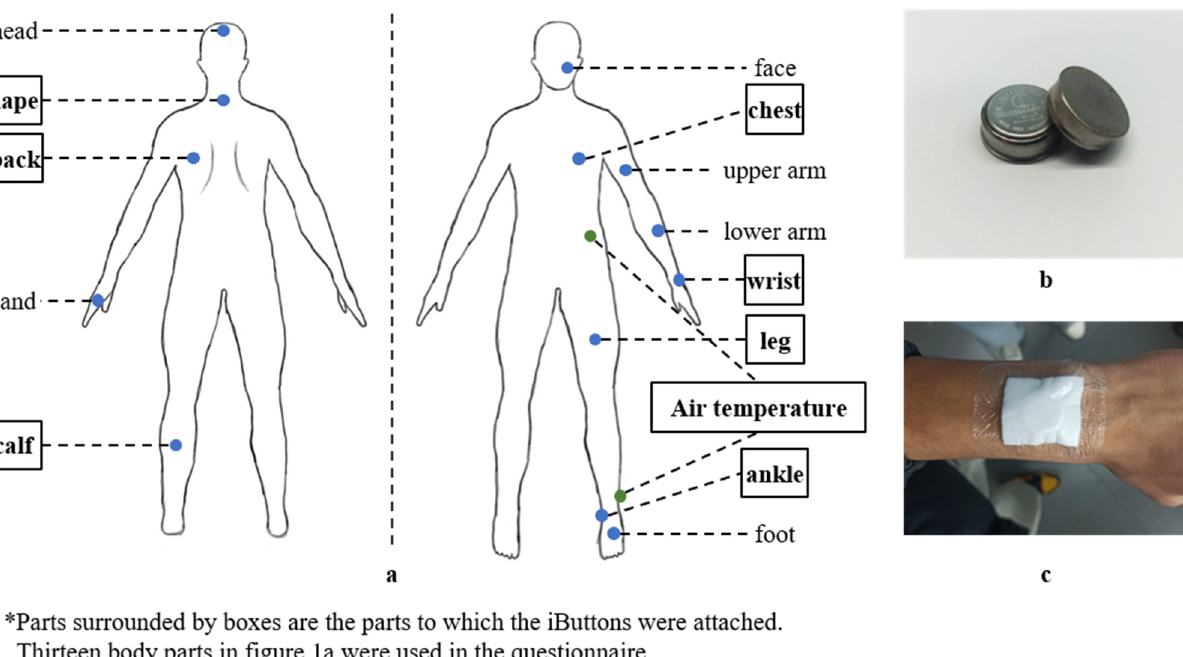
Figure 1. ( a ) A diagram of the 13 body parts; ( b ) iButtons; ( c ) an iButton attached to the skin.